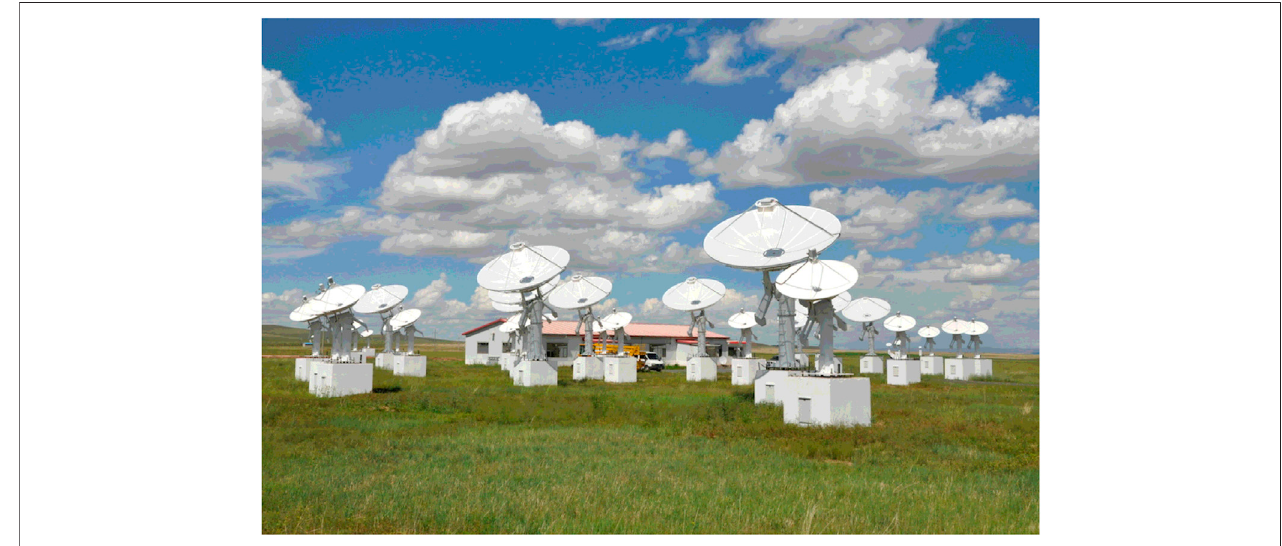
FIGURE 1 | Central part of MUSER-I and MUSER-II